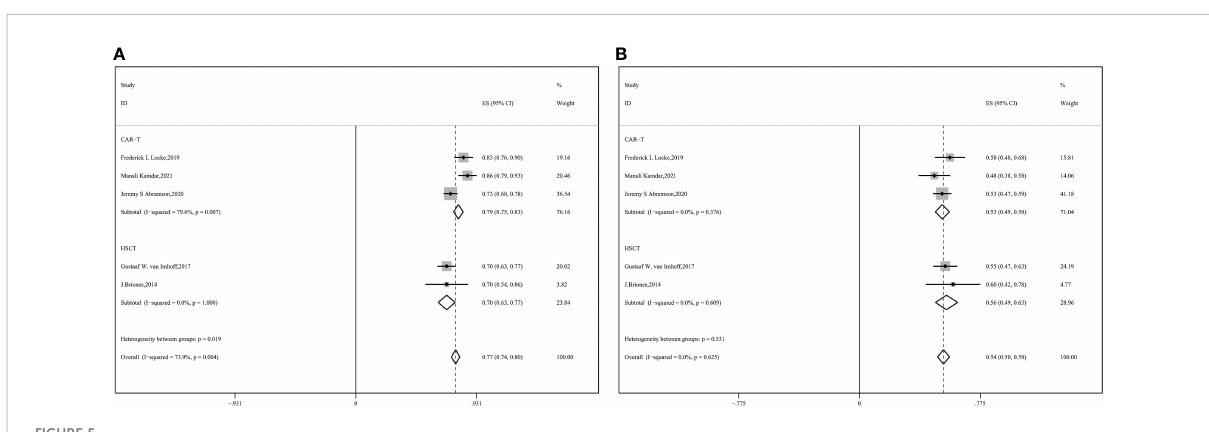
neoplasms with different clinical prognoses (39, 40). Patients